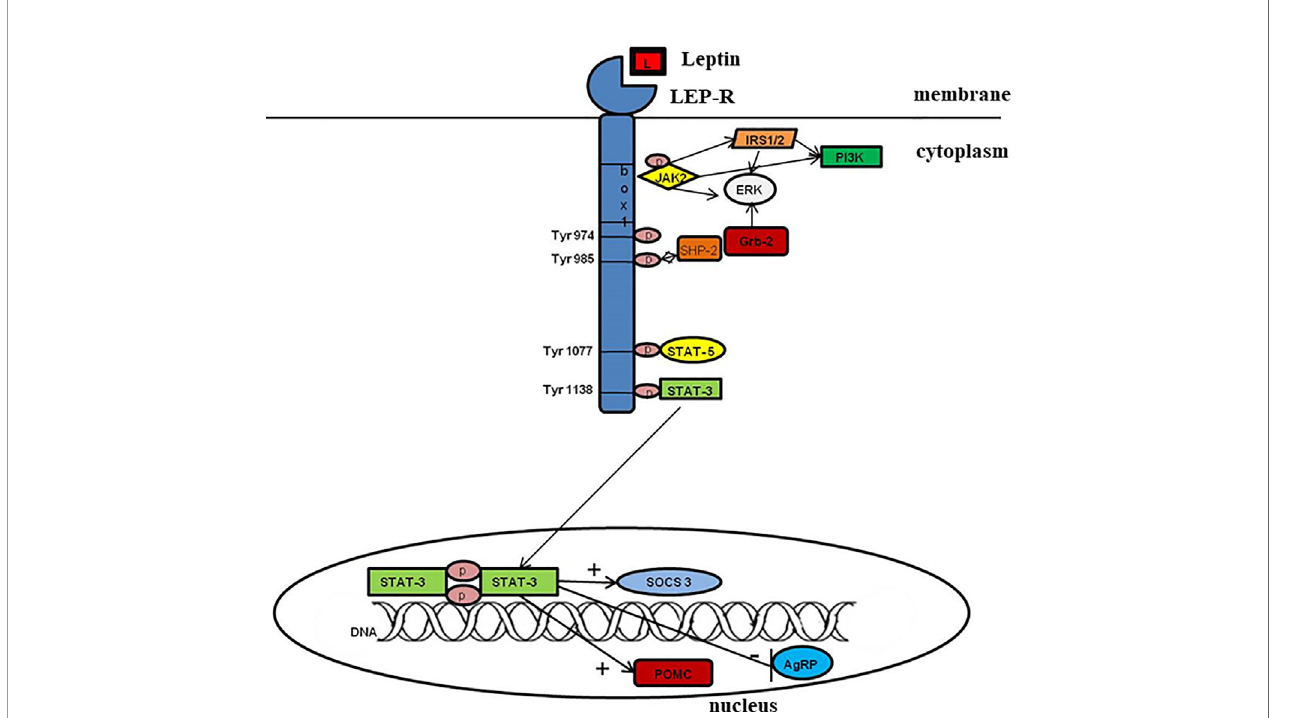
FIGURE 2 | Leptin signaling. L- leptin; LEP-R- leptin receptor; IRS 1/2, insulin receptor substrate 1/2; JAK 2, Janus kinase 2; PI3K, phosphoinositide 3-kinase; SH2, Src-like homology 2; SHP-2, SH2 domain-containing protein tyrosine phosphatase; SOCS3, suppressor of cytokine signaling 3; STAT, signal transducer and activator of